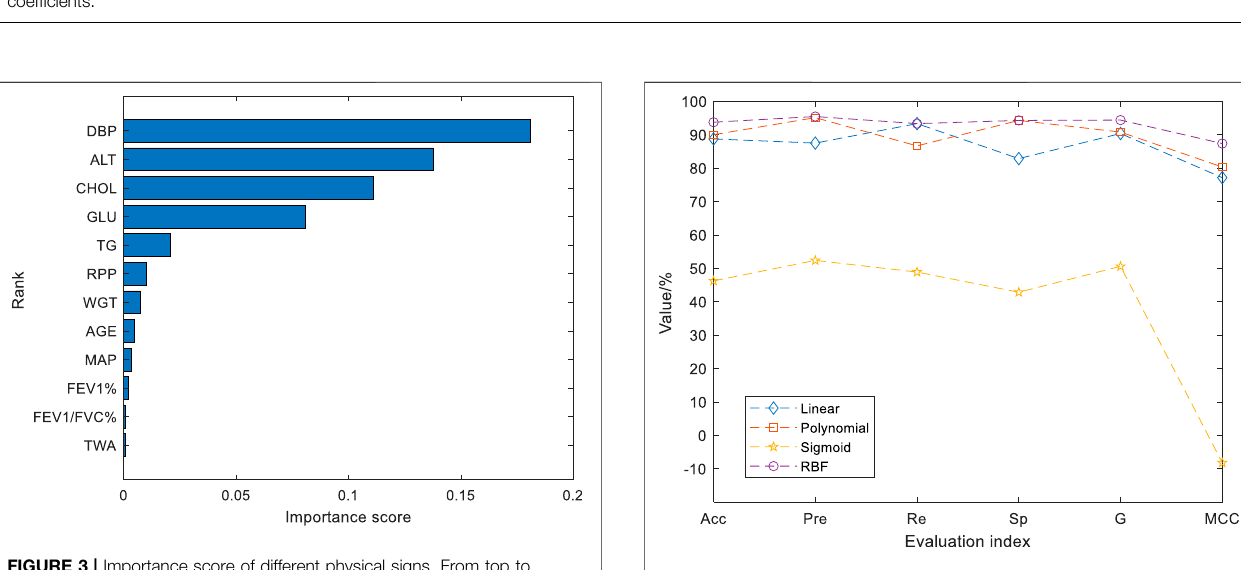
FIGURE 4 | Identi fi cation results of different kernel functions. The values of each evaluation index of RBF kernel function are high. The accuracy, precision, recall, speci fi city, G-mean, and MCC of the test set were 93.75%, 95.45%, 93.33%, 94.29%, 0.94, and 0.87. The values of each evaluation index of Sigmoid kernel function are